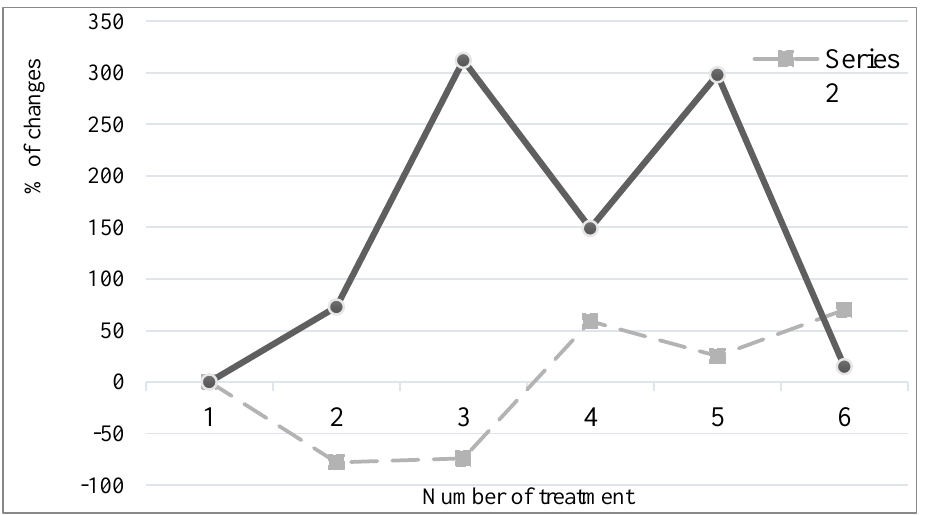
Figure 1. Effects of experiment variant on bacterial growth. Serie 1- TNB-(·10 7 in cfu/g); Serie 2- Bradyrhizobium (·10 3 in cfu/root nodule).